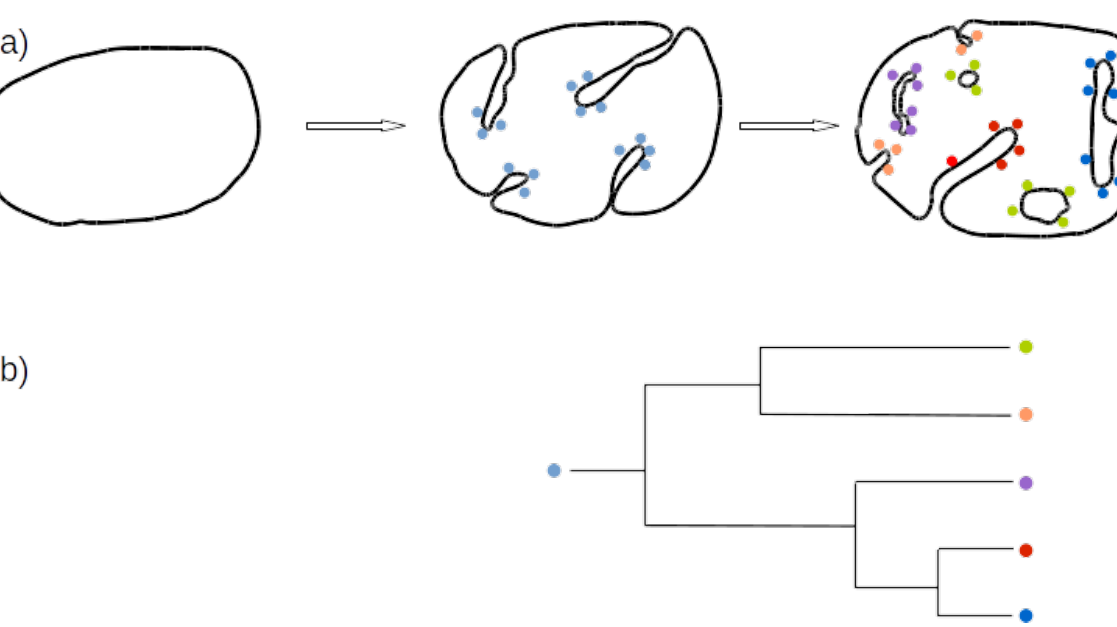
Figure 1. Early evolution of the endomembrane system, paralogous expansion and evolution of membrane manipulation complexes. ( a ) Early evolution of the endomembrane system can be divided into three steps: (1) a prokaryote without additional features to its external membrane other than surrounding it; (2) acquisition of multi-protein complexes for membrane manipulation (e.g., MC proteins) allowed this organism to invaginate and manipulate its membrane; and 3) duplication and evolutionary divergence led to spatial separation and functional differentiation of the compartments formed. For clarity, only the MC proteins are represented (coloured spheres). Proteins of the same family have the same colour; ( b ) Illustrative-only phylogenetic tree of MC proteins. After the initial birth of this protein (blue sphere), duplication and divergence lead to different protein families (coloured